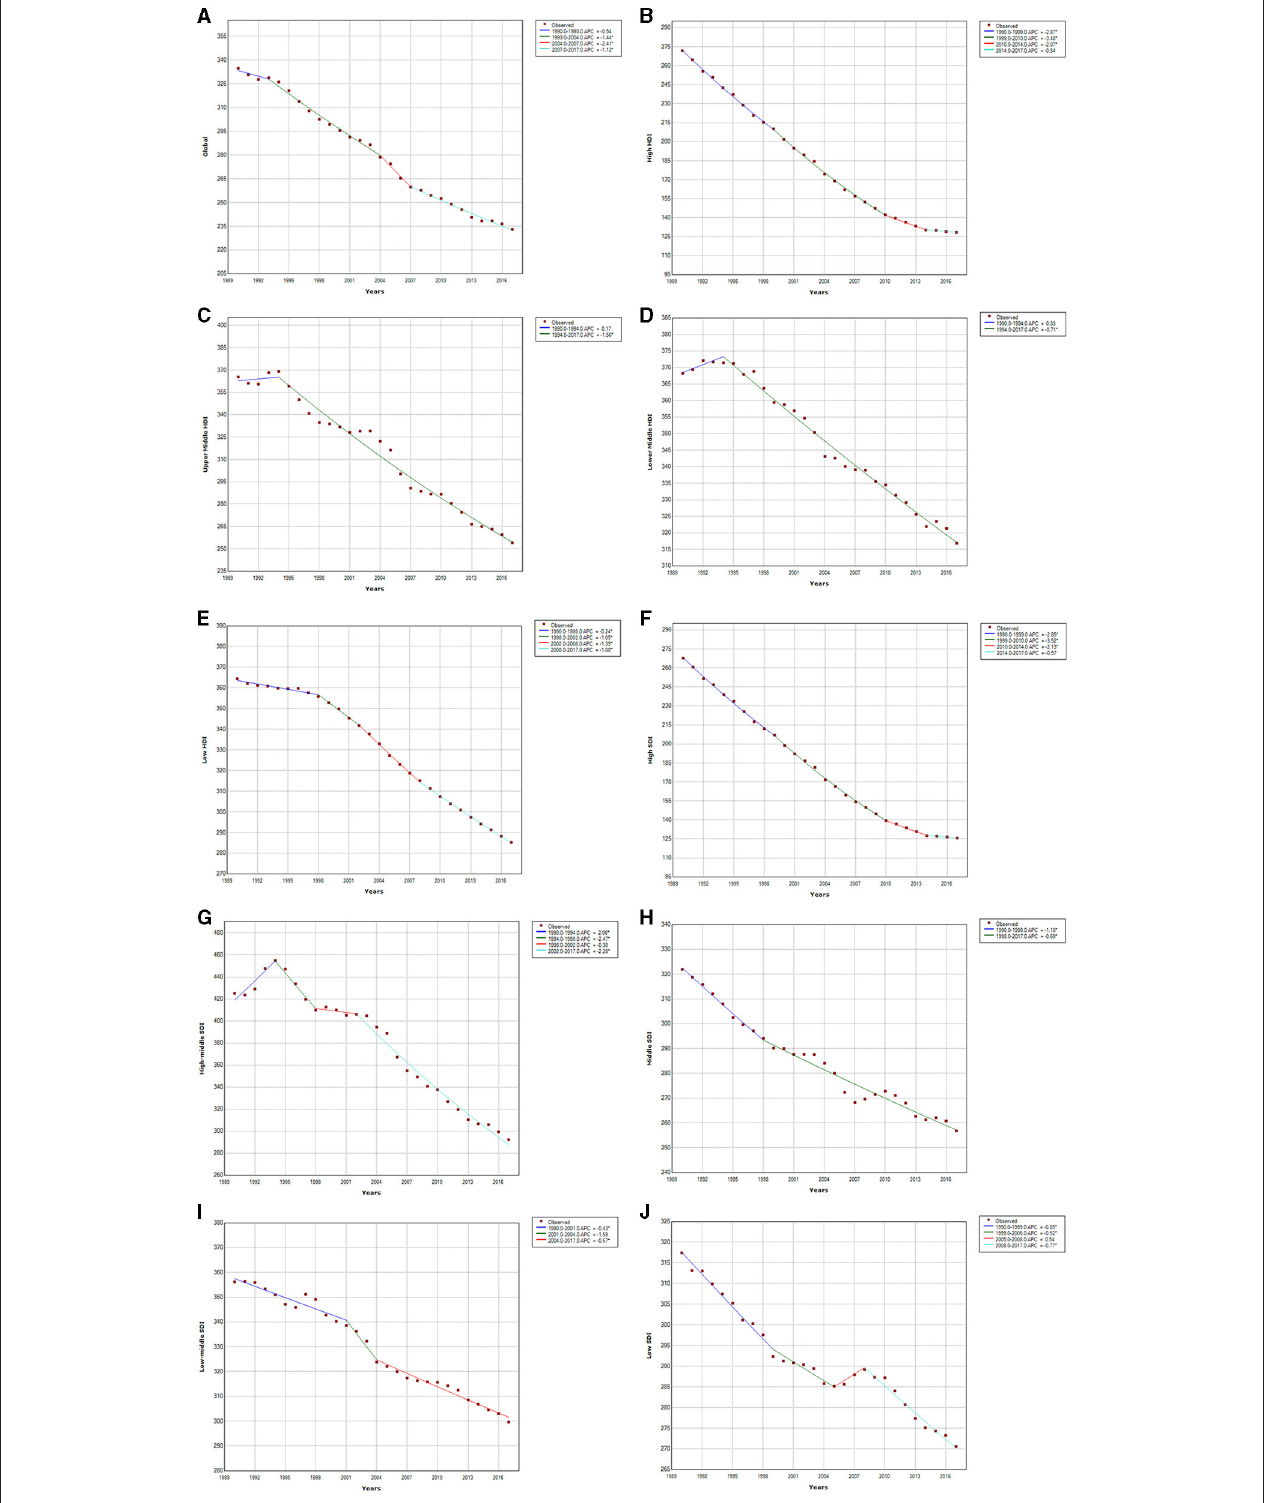
FIGURE 8 | Cardiovascular disease trends in global, HDI, and SDI regions ASDR from 1990 to 2017. Global (A) ; high HDI (B) ; upper middle HDI (C) ; lower middle HDI (D) ; low HDI (E) ; high SDI (F) ; high-middle SDI (G) ; middle SDI (H) ; low-middle SDI (I) ; low SDI (J) .